Question: Name the type of graph shown.
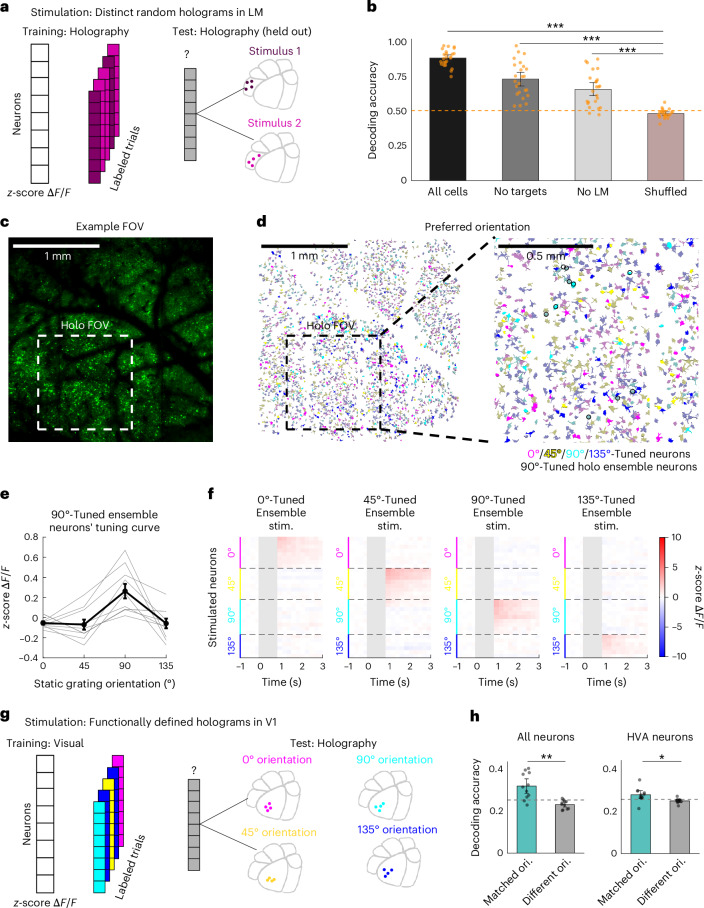
Answer: line